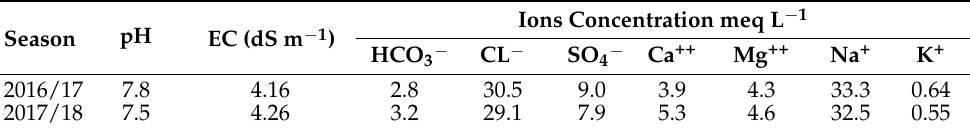
Table 3. Chemical properties of irrigation water at the experimental site during 2016/2017 and 2017/2018